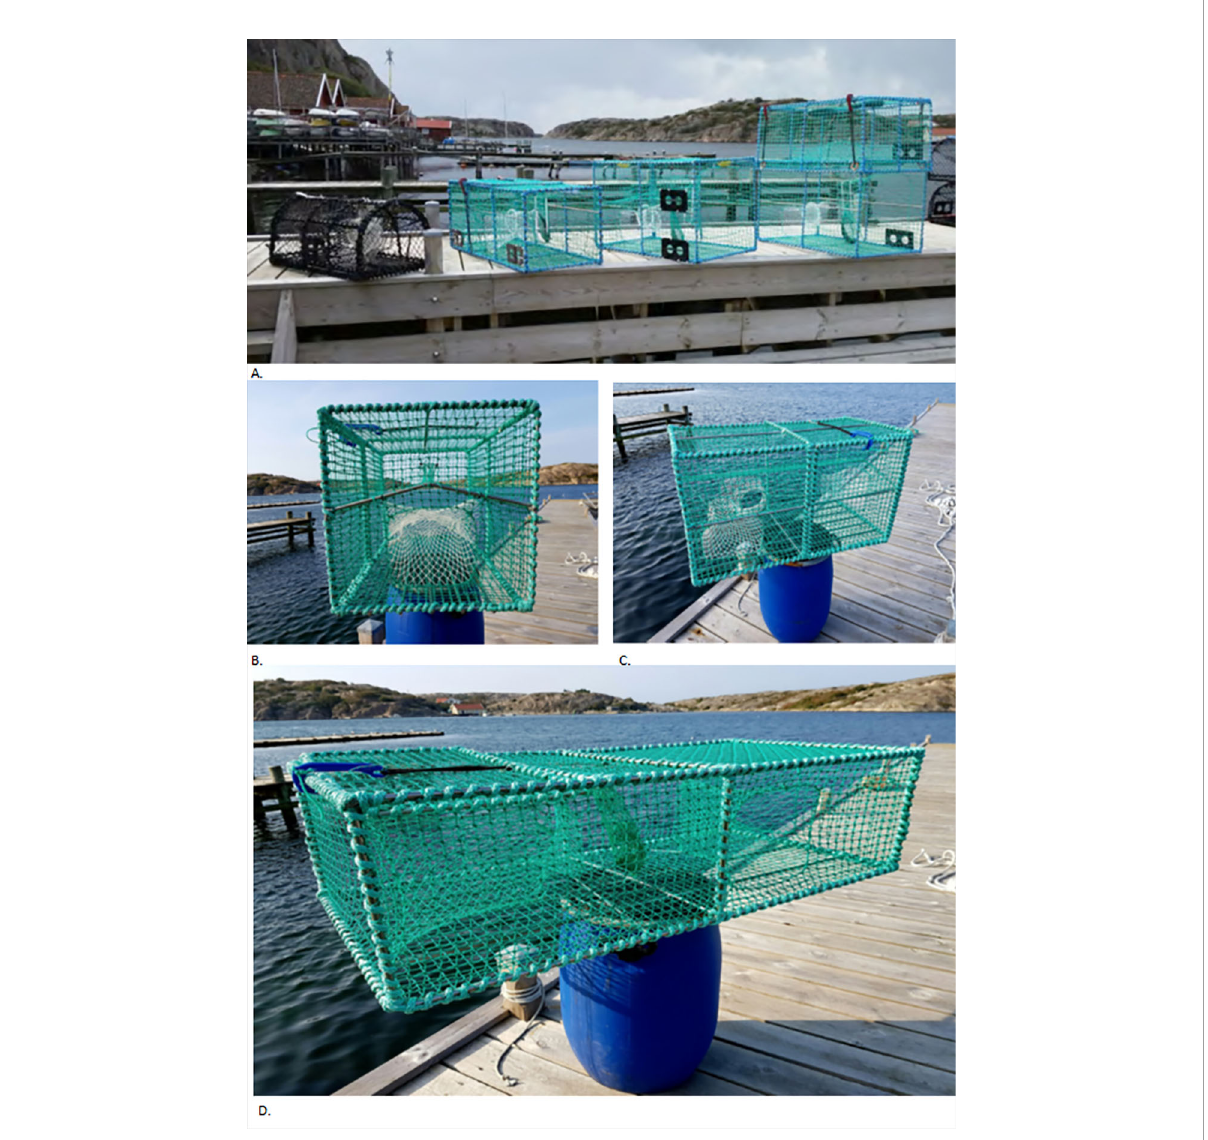
which have four closed, green, vertically placed funnel